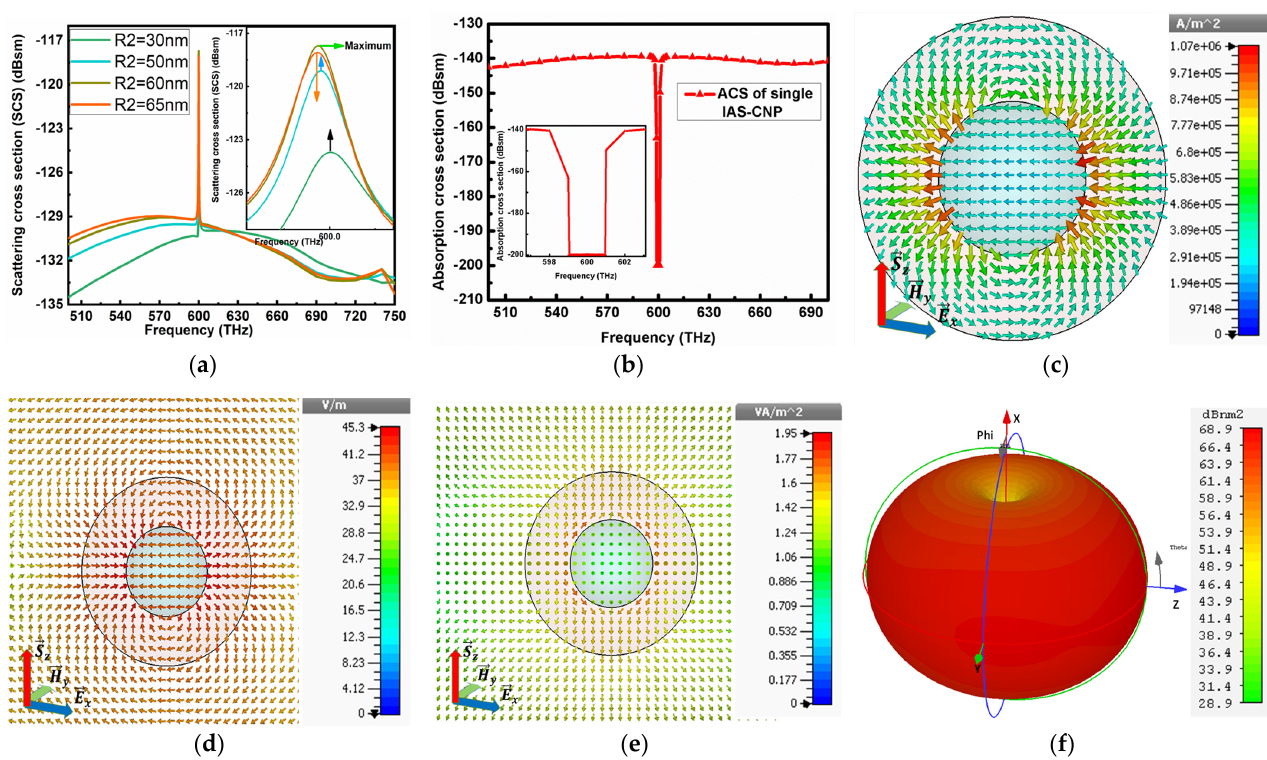
Figure 3. ( a ) SCS peak, ( b ) ACS peak, ( c ) electric current density, ( d ) electric field pattern, ( e ) power flow pattern and ( f ) far-field pattern at resonance frequency for individual I-CNP model.